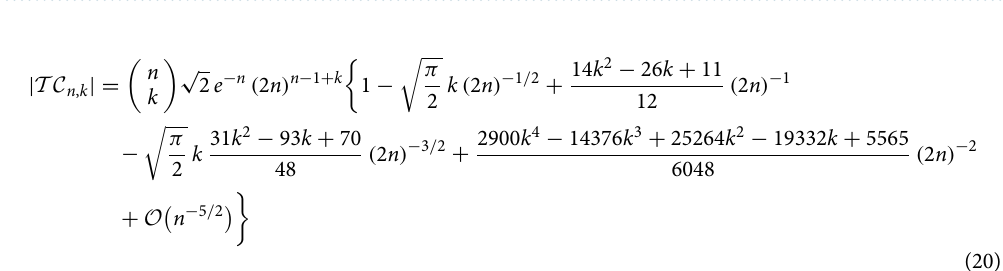
T C n , k 4 and 5. The deviation is versus n , for two particular cases, k | | = Approximated 1 Exact − =